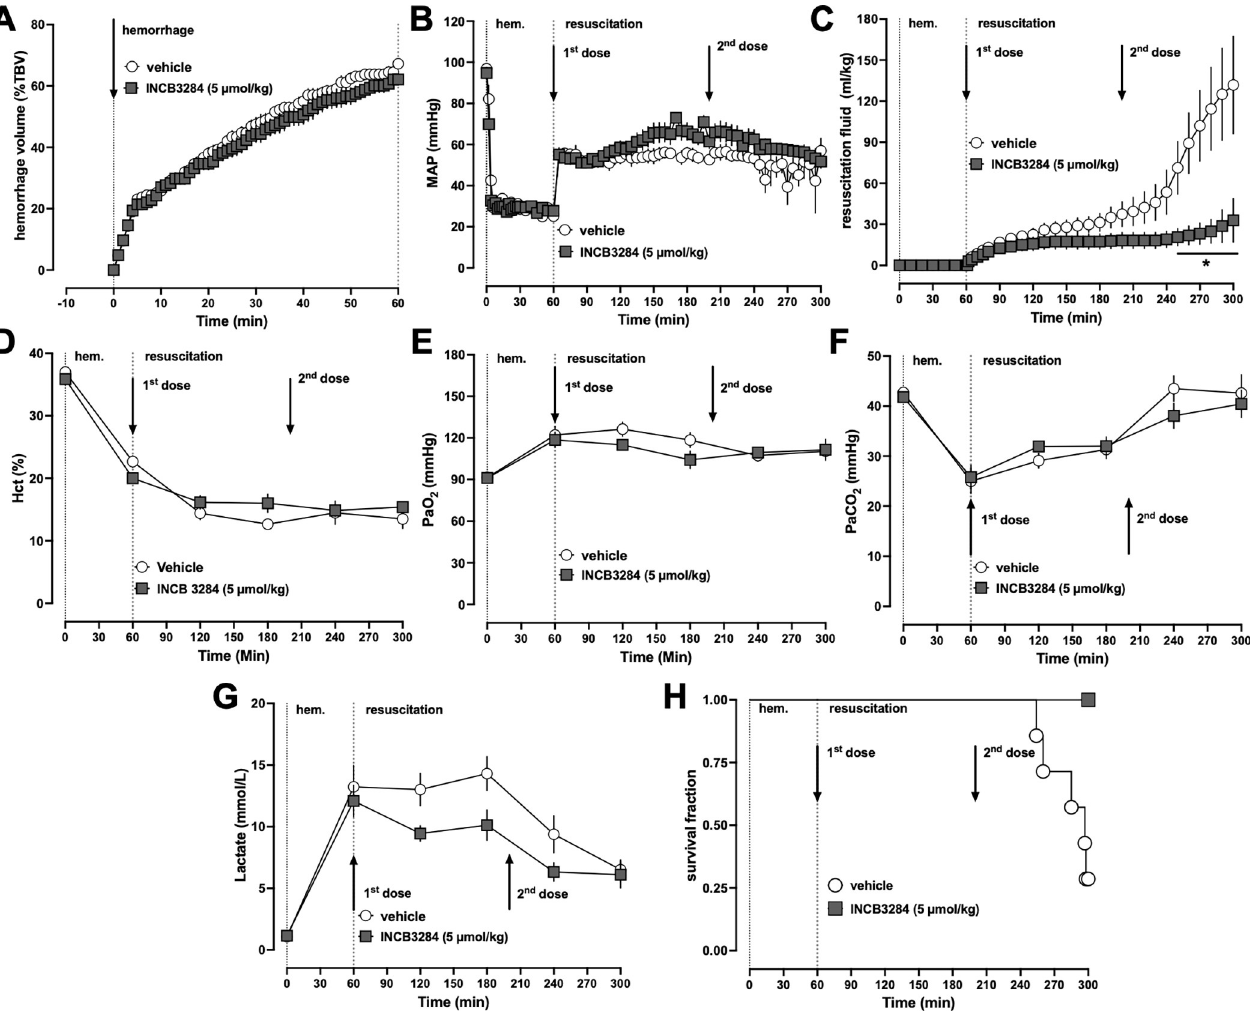
Fig 3. Redosing of INCB3284 reduces fluid resuscitation requirements after 60 min of hemorrhagic shock. All data are mean ± SE. Arrows represent the time points of drug/vehicle injection. Open circles: animals treated with vehicle (n = 7). Grey squares: animals treated with 5 μ mol/kg INCB3284 (n = 7). * : p < 0.05 vs. animals treated with vehicle. (A) Hemorrhage volumes for maintain mean arterial blood pressure (MAP of 30 mmHg). %TBV: percent of total blood volume. (B) MAP (mmHg) (C) Fluid resuscitation in mL/kg required to maintain MAP of 60 mmHg or systolic blood pressure (SBP) of 90 mmHg. (D) Hct%: Hematocrit values in %. (E) PaO 2 : Partial pressure of oxygen in arterial blood. (F) PaCO 2 : Partial pressure of carbon dioxide in arterial blood. (G) Plasma lactate concentration (mmol/L). (H) Kaplan-Meier survival